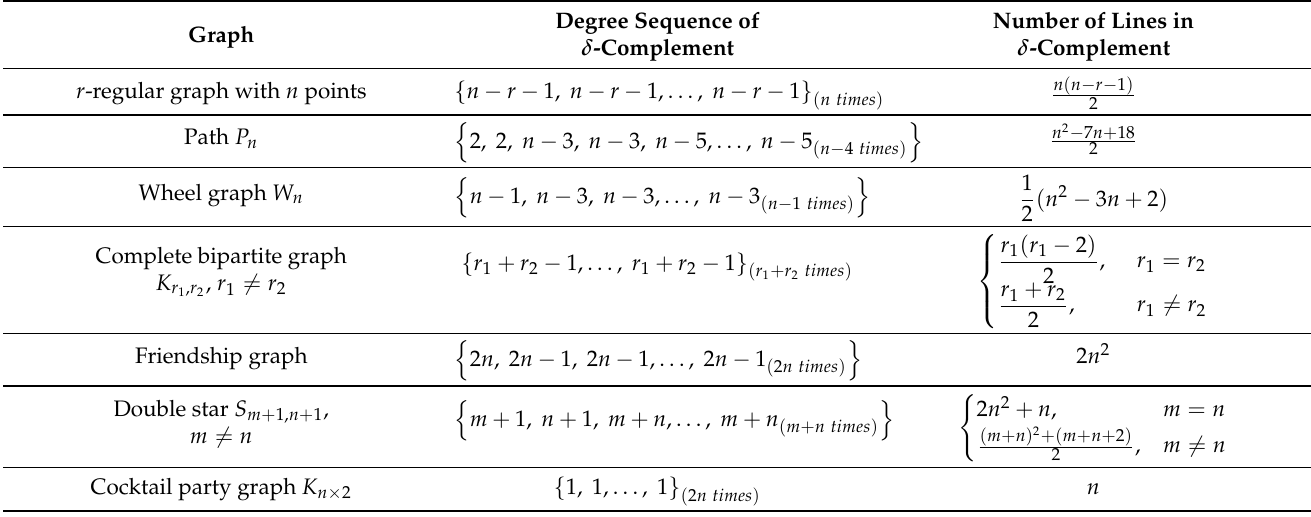
Table 1. The degree sequence and number of lines in δ -complement of various graphs.